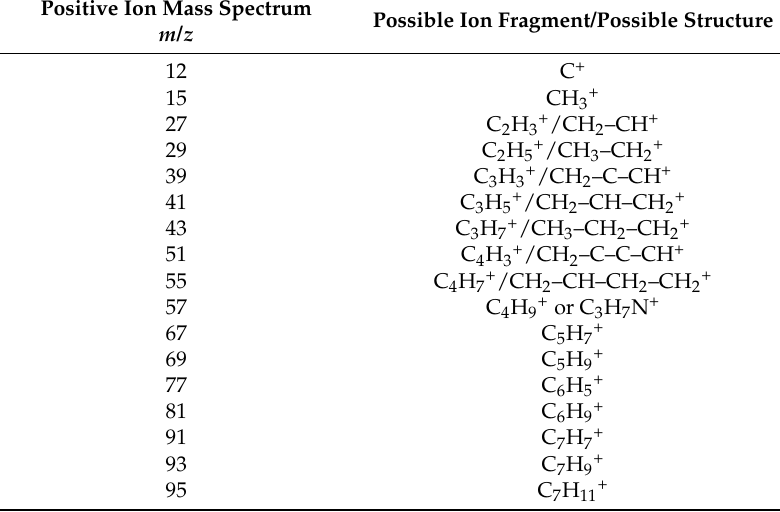
Figure 8. Positive-ion ToF-SIMS narrow range spectra (0–100 amu) of PANI film surfaces grown on glass substrates using advanced APPJs device after 60 min deposition: ( a ) without I 2 doping; ( b ) with 30 s I 2 doping; and ( c ) with 120 s I 2 doping following deposition. Table 4. Selected peaks and their assignments observed in positive-ion ToF-SIMS spectra of PANI. Positive Ion Mass Spectrum